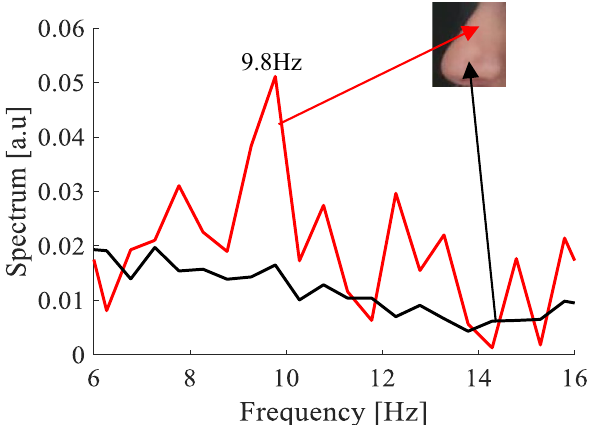
Figure 4. Detection of cilia vibration using the endoscopic configuration. Images were taken through an endoscope with laser illumination. The correlation spectrum extracted from the analysis of the speckle patterns ( a ) from the ciliated mucosa area, presents a peak in the spectrum at a frequency around 9.8 Hz, and ( b ) in the lumen of the nasal cavity no apparent peak exists.